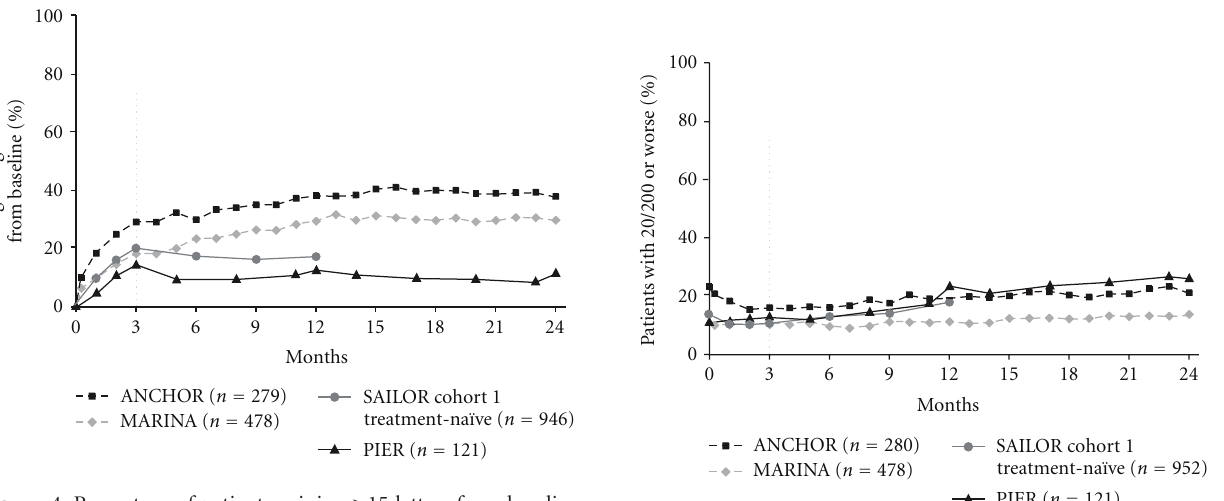
Figure 4: Percentage of patients gaining ≥ 15 letters from baseline over time among pooled ranibizumab-treated patients by clinical trial. Dosing: ANCHOR and MARINA, monthly; PIER, months 0, 1, 2, 5, 8, 11, 14, 17, 20, and 23; SAILOR, months 0, 1, and 2, then as needed. Vertical line indicates switch from monthly to quarterly and as-needed dosing in PIER and SAILOR, respectively.